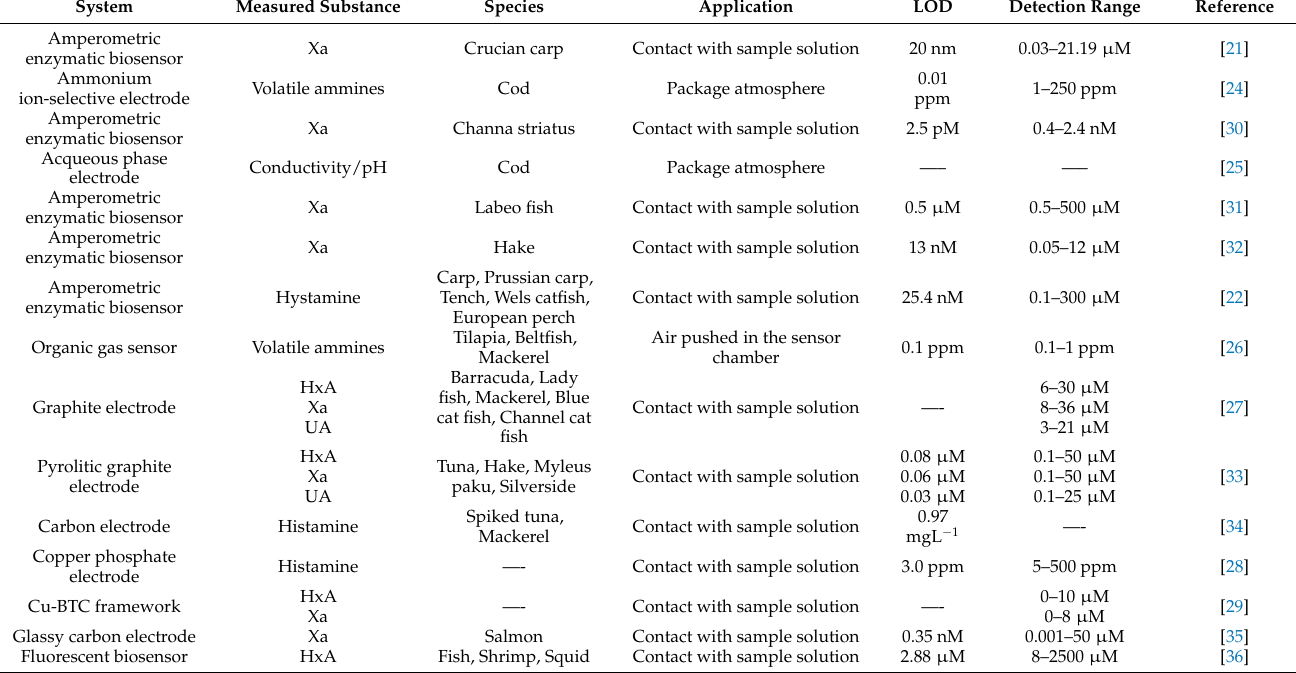
Table 1. Analytical and chemical